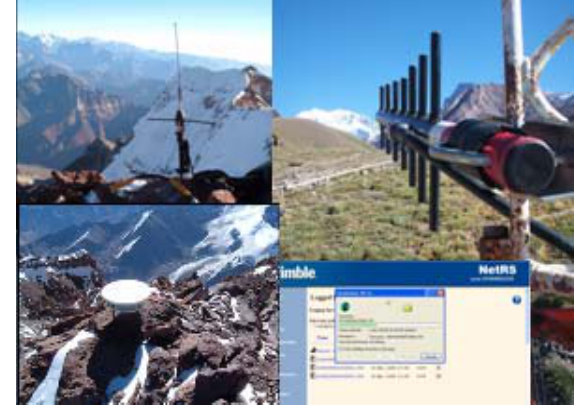
Figure 2. Station ACON. Data Transmission from the Summit Fig. 2. Station ACON. Data Transmission from the